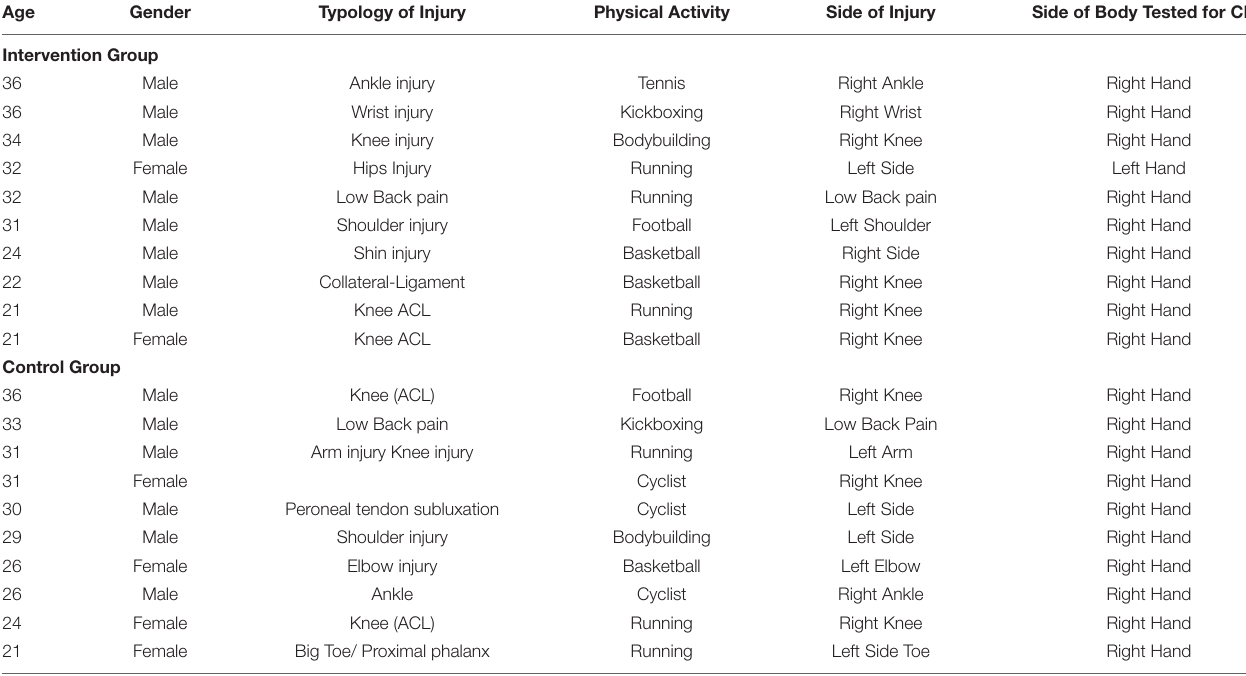
TABLE 1 | Demographic details for each participant in each of the groups in terms of age, gender, clinical characteristics of the injury and sporting activities. Age Gender Typology of Injury